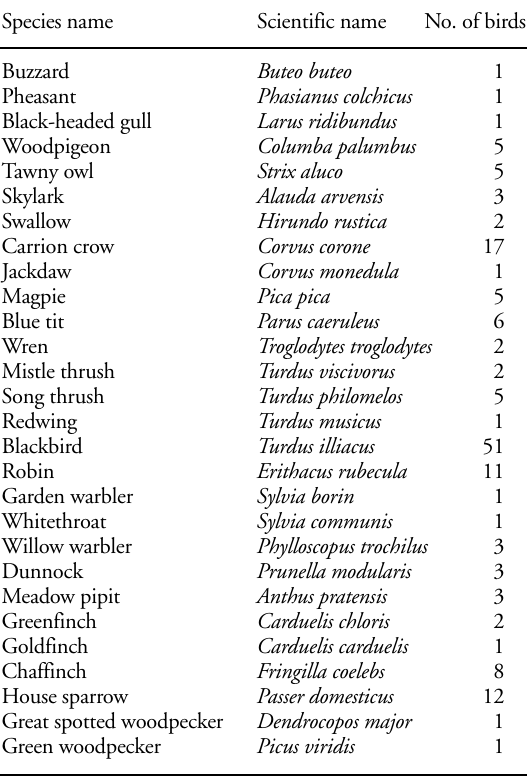
Table 1b. Number of bird road casualties in this